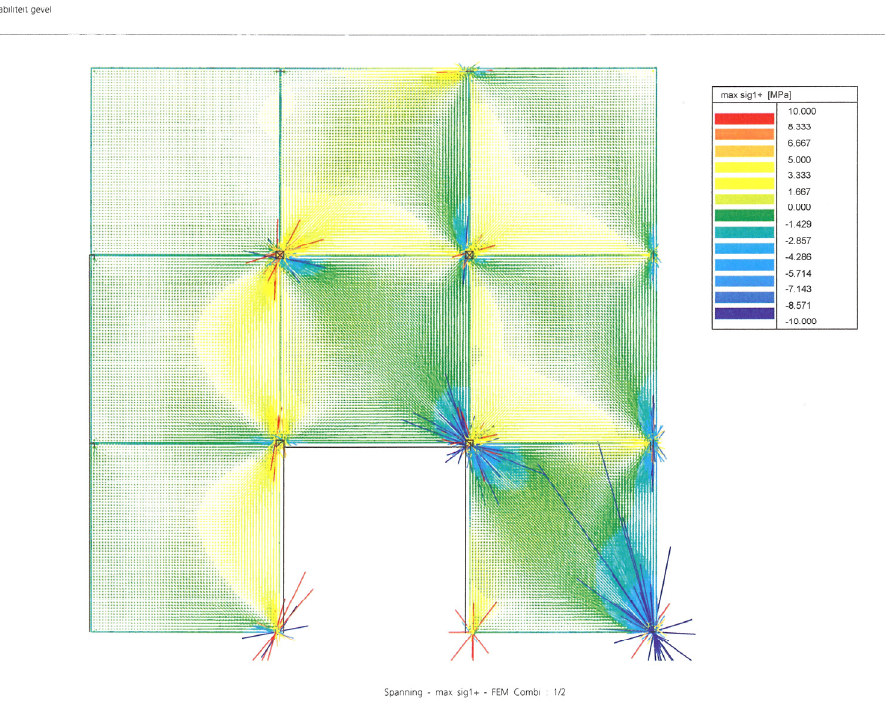
Figure 7: The flow of stability stresses through the façade with the big